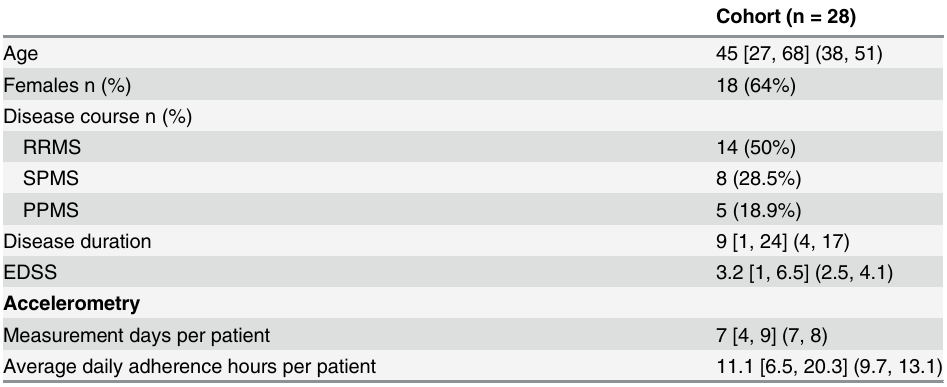
Table 1. Descriptive statistics of the